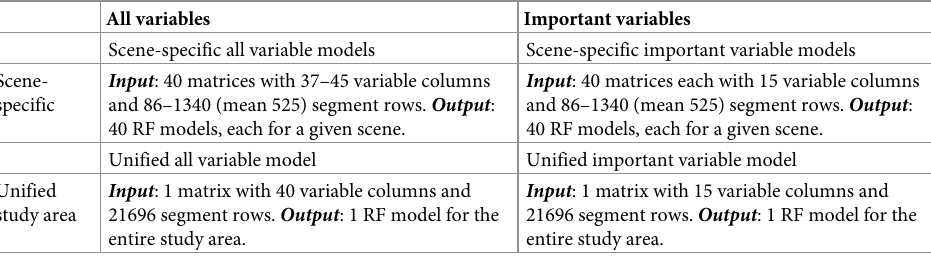
Table 2. Summary of model